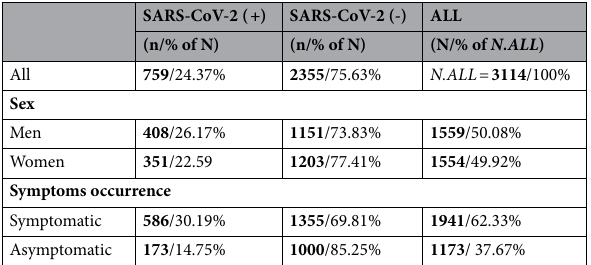
Table 1. Summary of data based on demographic profile. One patient did not provide information regarding sex.